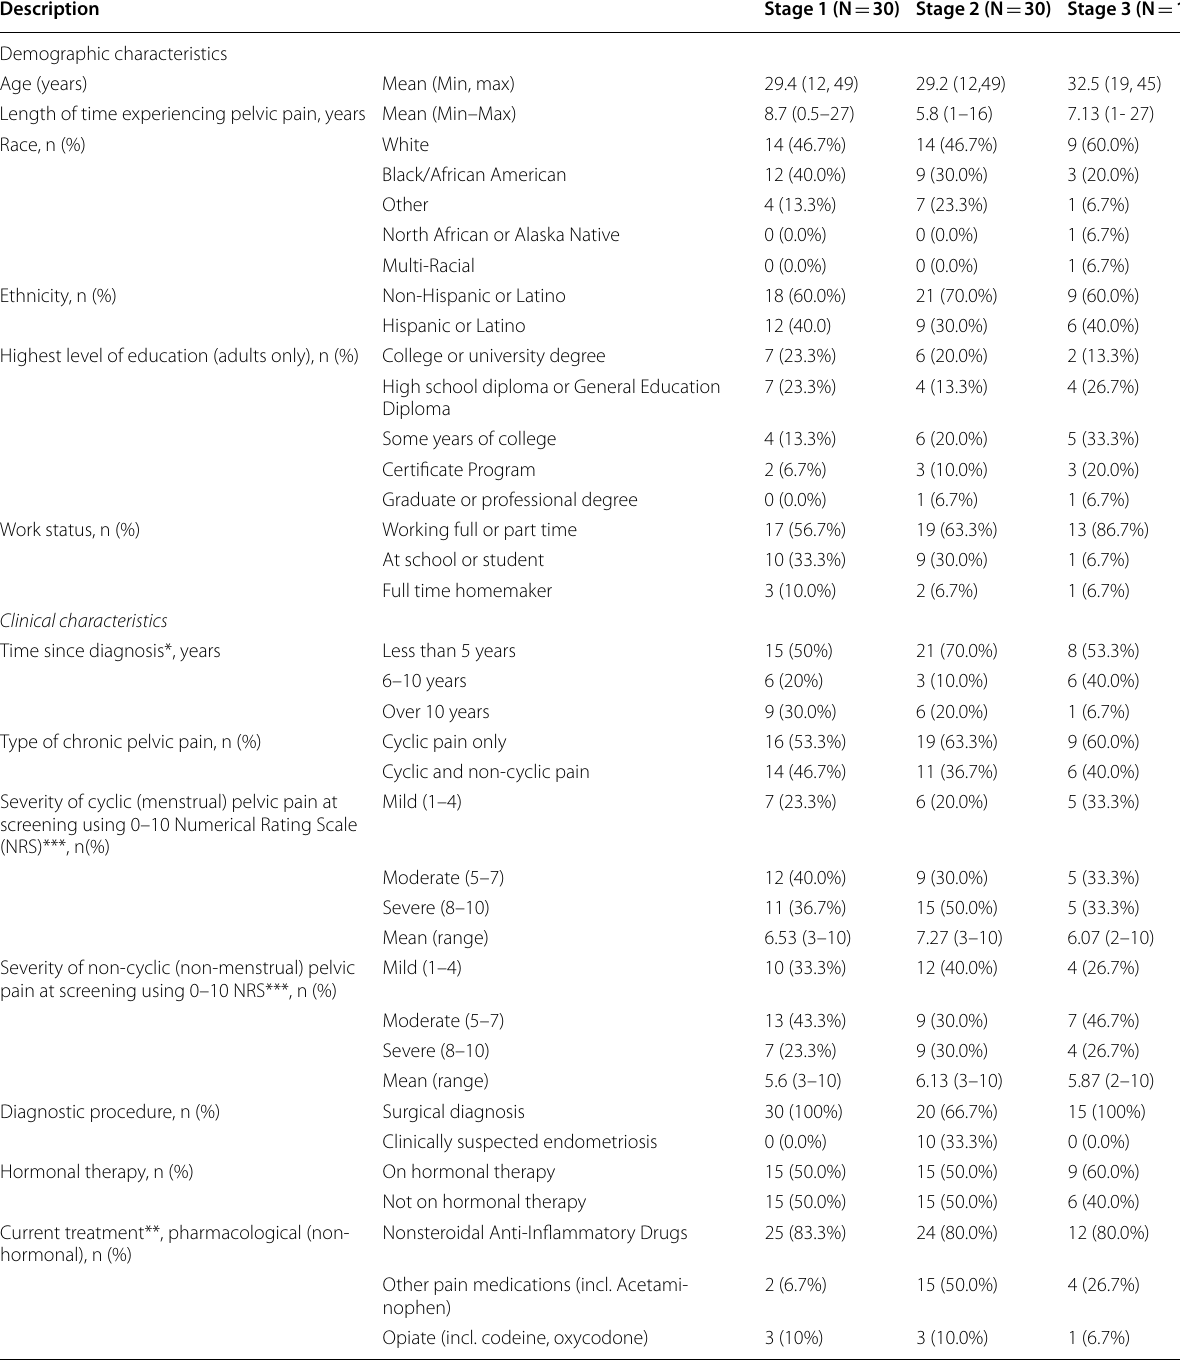
Table 1 Demographic and clinical characteristics of each sample across